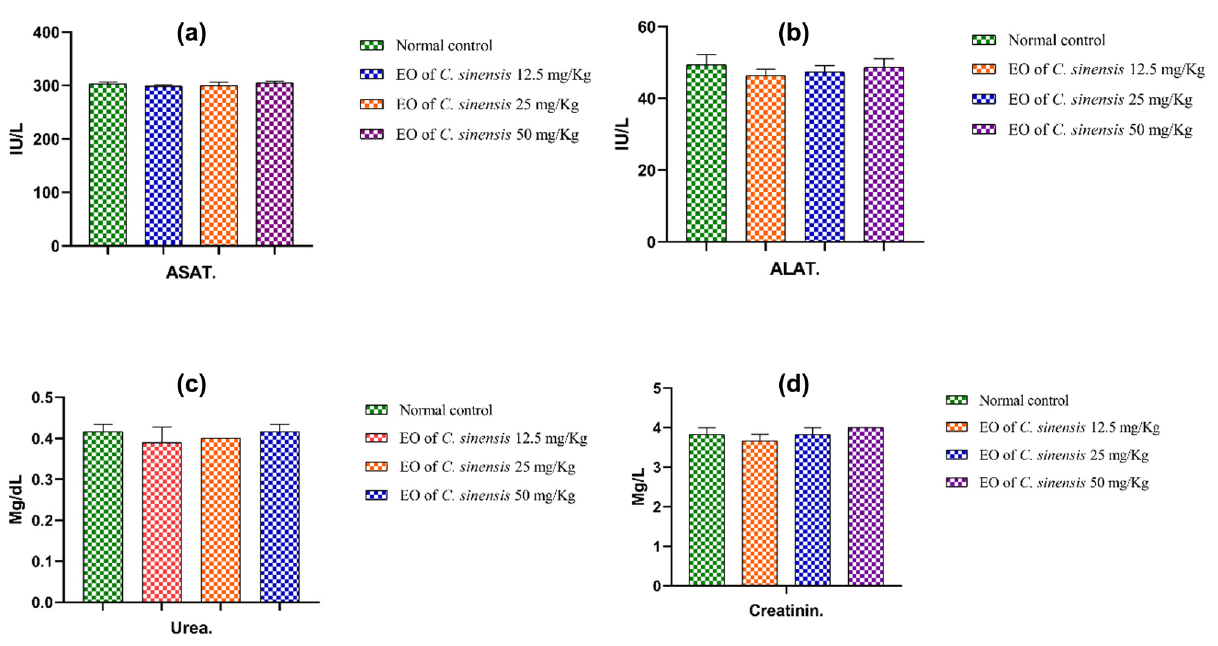
Figure 7: ( a ) The serum levels of “ ASAT ” of control and treated mice; ( b ) serum levels of “ ALAT ” of control and treated mice; ( c ) level of serum “ urea ” of control and treated mice; and ( d ) serum “ creatinine ” level of control and treated mice. The values are expressed as mean ± SD ( n = 5 ) .